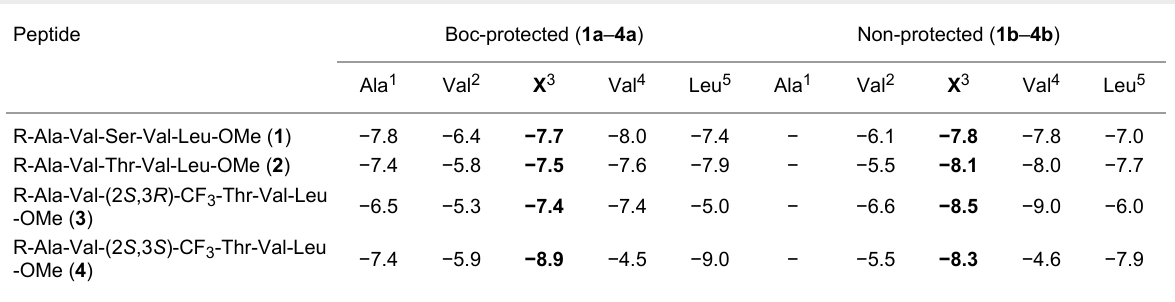
Table 5: Temperature coefficients Δδ / Δ T (ppb K − 1 ) for HN protons in pentapeptides 1a – 4a and 1b – 4b in CD 3 OH (298 K).